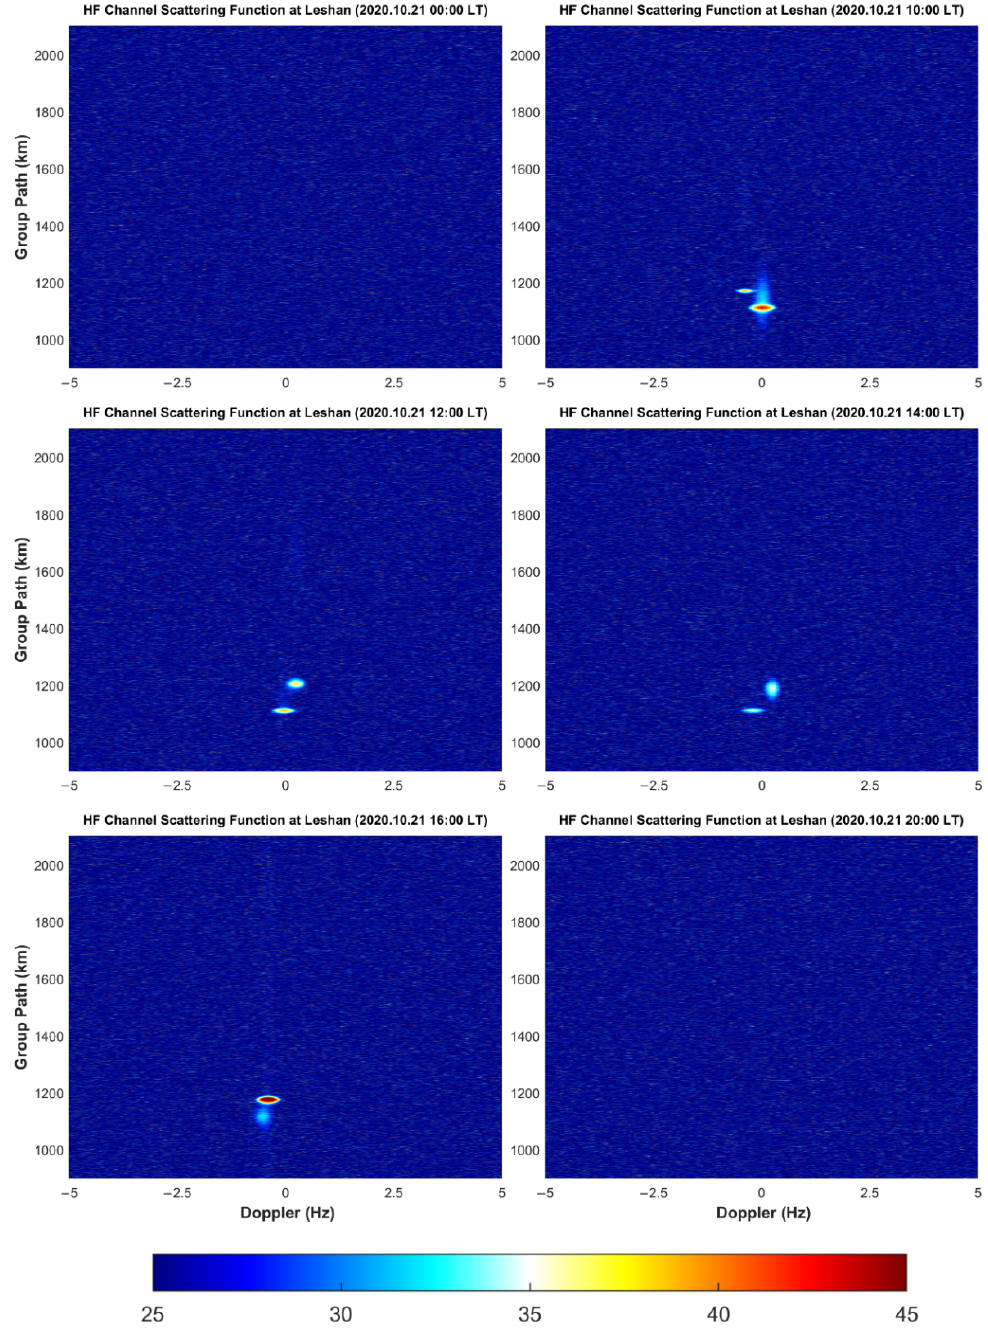
Figure 10. 21 October 2020, modeling and simulation results of the HF channel at Leshan station. The redder the color in the figure, the stronger the received energy. The color bar’s unit is dB ( 1 µ V / m )